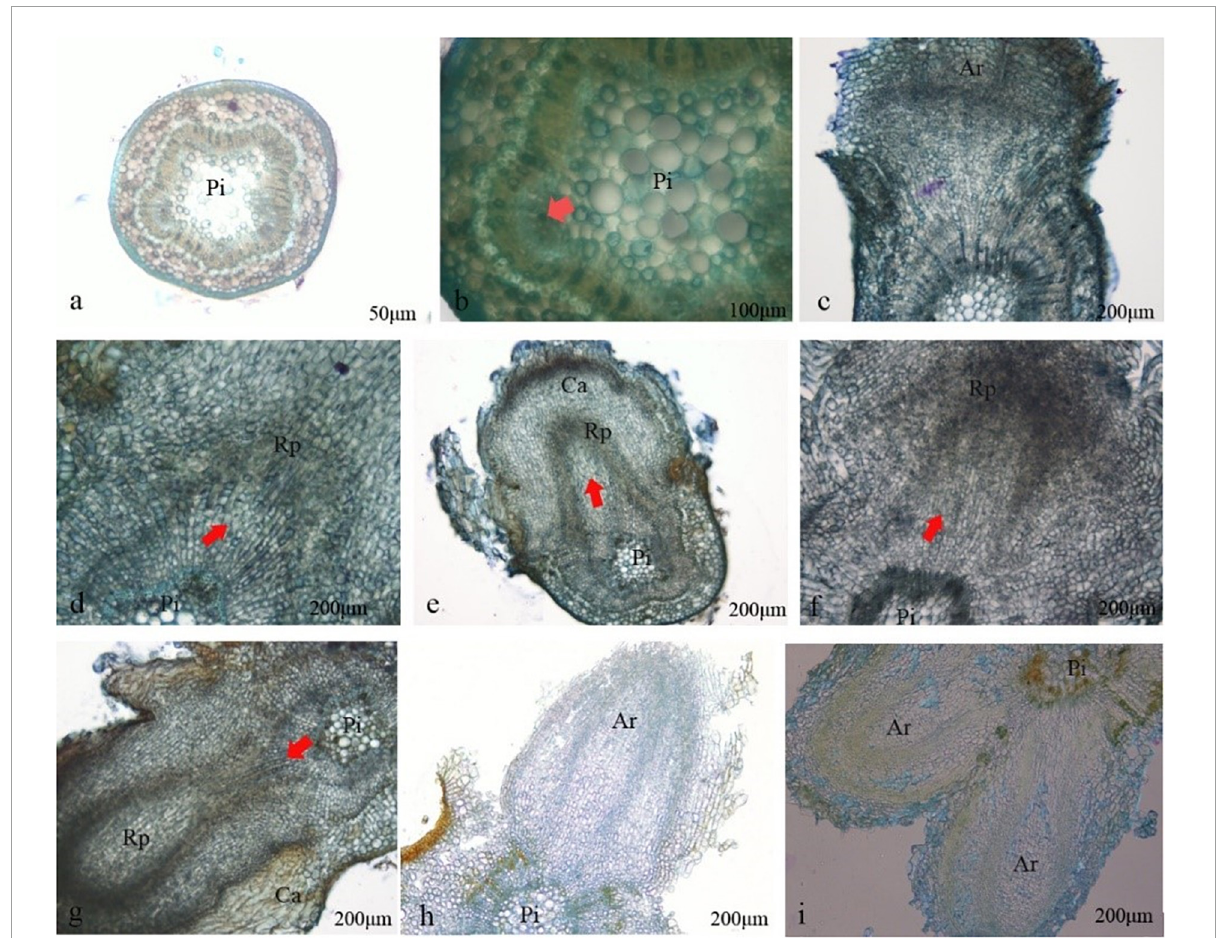
FIGURE3 Histology observation on differentiating roots formation of Castanopsis hystrix plantlets. Ri, pith; Rp, root primordium; Ar, adventitious root; Ca, callus. (a) Rooted on day 4; (b) the cambium cells were active on day 5; (c) callus appeared; (d) root primordium appeared on day 7; (e,f) root primordium differentiated; (g) adventitious root broken through the cortex on day 11; (h) adventitious root broken through callus on days 12–13; (i) the adventitious root vascular connected to the stem